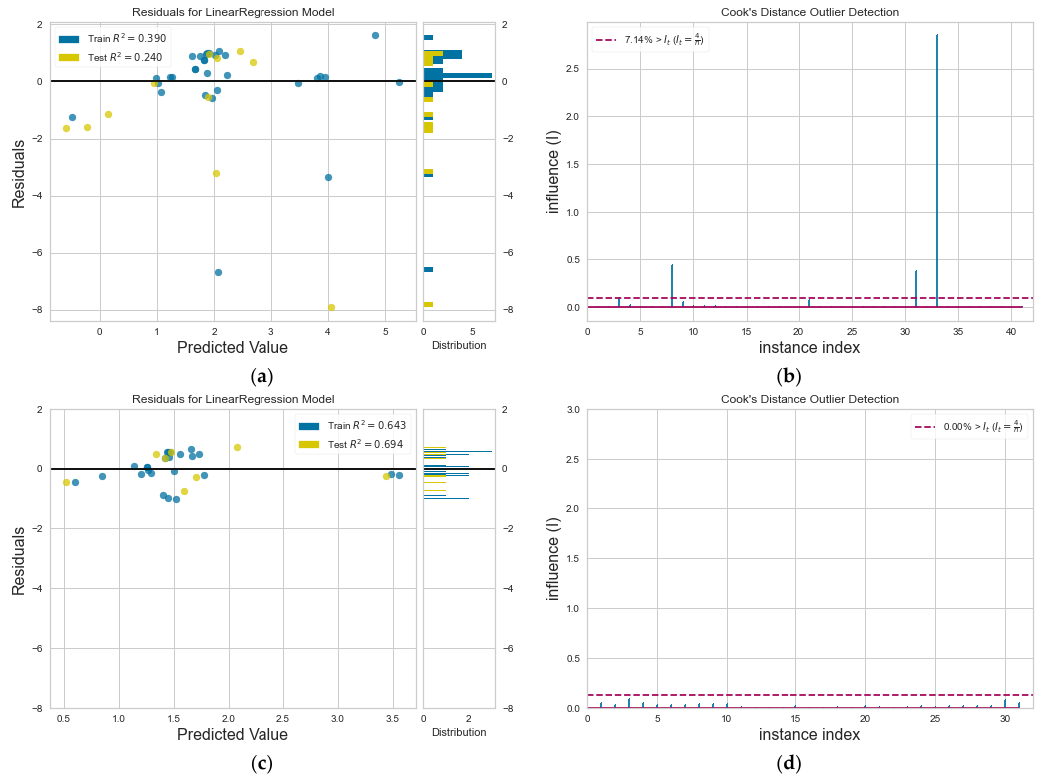
Figure 7. ( a ) Residuals plot and ( b ) Cook’s distance for η , and, after the removal of outliers from the dataset, ( c ) new residuals plot and ( d ) new Cook’s distance. For thermal conductivity, k , the residual plot in Figure 8a shows good accuracy for training data. We must point out that small R 2 in test data is circumstantial, since our model selects randomly from the dataset which data to consider as train and test. The Cook’s distance (Figure 8b) depicts two outliers, and after their removal, we observe that ratio (strongly hydrophilic wall) is R 2 is improved for test data. The large 2 5 w f also responsible for the outliers in thermal conductivity values. We note that thermal conductivity has shown remarkable accuracy to the regression method investigated here.